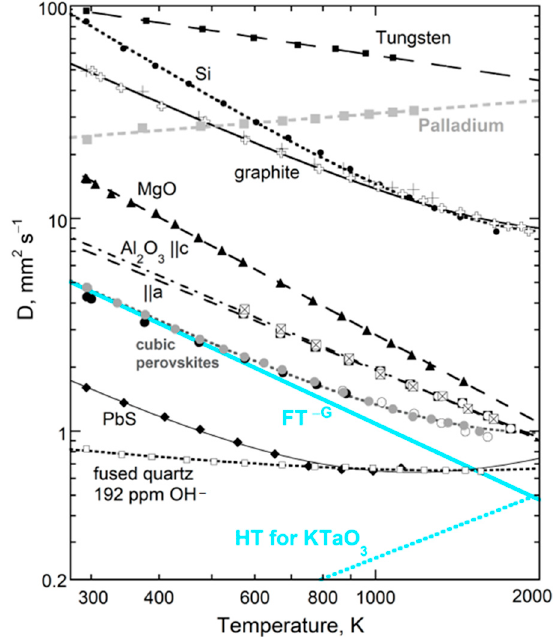
Figure 4. Log-log plot of thermal diffusivity vs. temperature for metals and single-crystal insulators with nearly end-member compositions, as labeled. Structures are various. Thickness, fits, and data sources are shown in Table 1. Because synthetic sapphire is thin, low T data points were not used in fitting (see below). Components of the fit for KTaO 3 perovskite are shown in thick aqua solid and dotted curves.